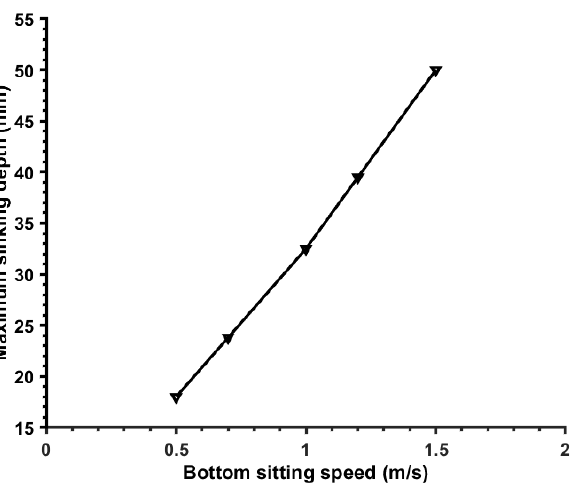
Figure 14. The subsidence depth versus time of the benthic lander sinking into the sediment.